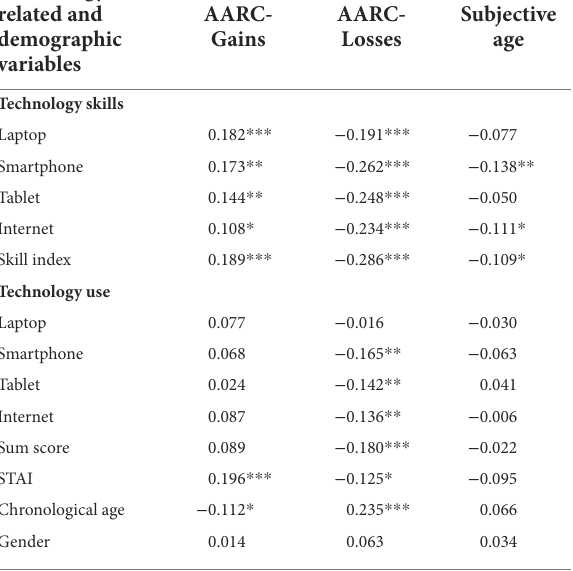
TABLE 1 Correlations between AARC (Gains and Losses), SA and technology-related